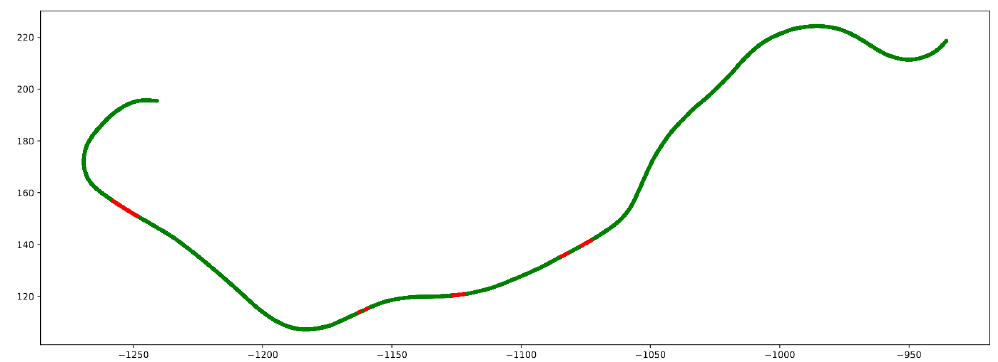
Figure 3. Sample of the path where the network status is showed in green when active and in red when the host is